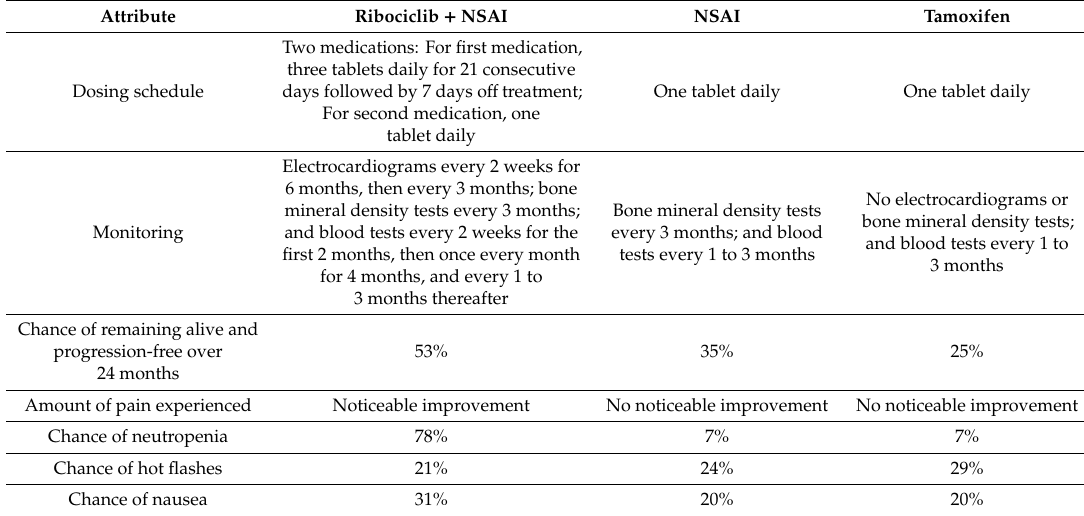
Table 2. Attributes profiles for treatments of advanced breast